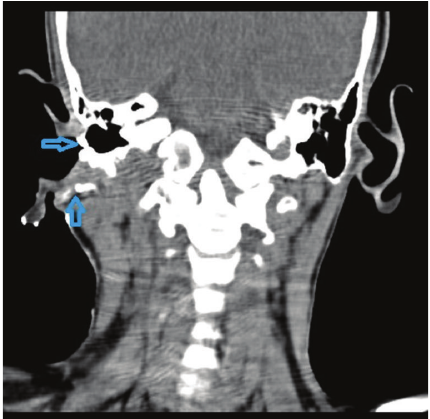
Figure 3: CT fistulogram with coronal reconstruction (posterior to Figure 2) showing the bifurcation of the fistula tract; one opening into the external auditory canal (shown by right facing arrow) and other going to retroauricular region (shown by upward